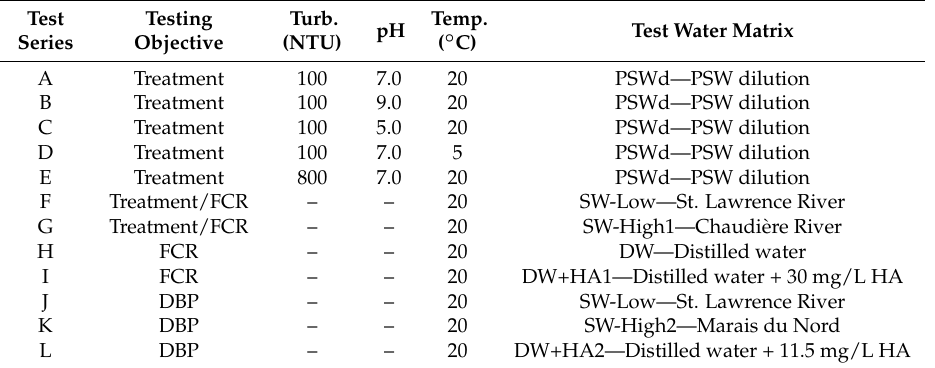
Table 1. Summary of test series and corresponding (adjusted) target test water